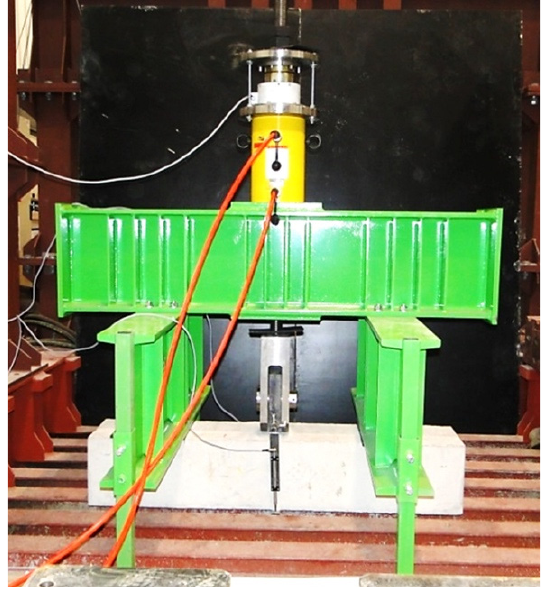
Figure 5. Test setup.